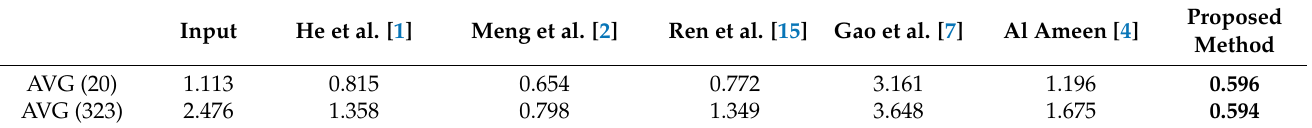
Table 12. The comparison of the FADE [36] average scores on the sample images (Figures 6 and 7) and DWAN dataset [32] (If the score is low, the image is enhanced well. The lowest scores are indicated in bold